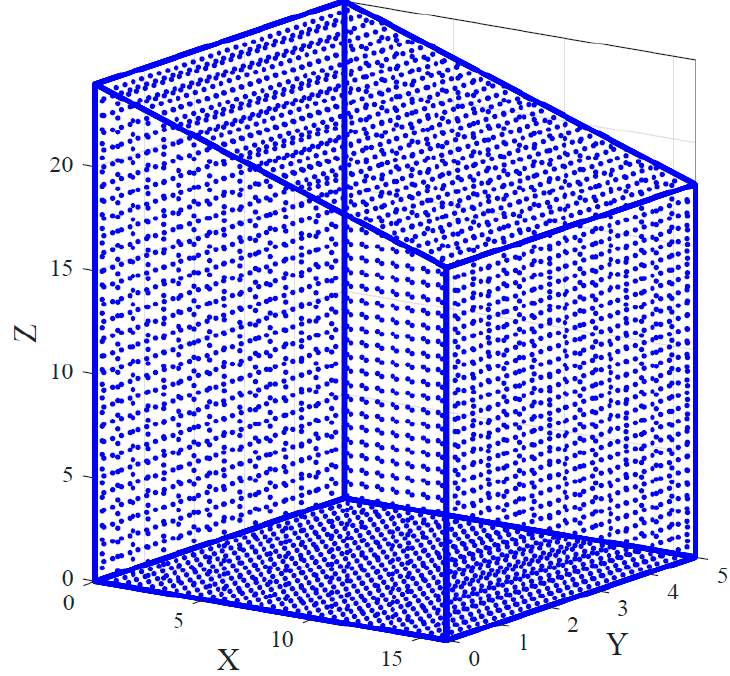
Figure 12. Collocation points on the three-dimensional boundary.